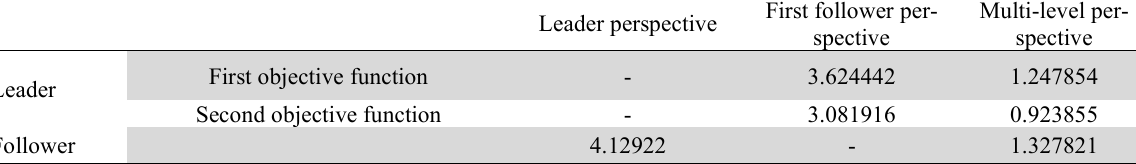
First follower per- Multi-level per- Leader perspective spective spective